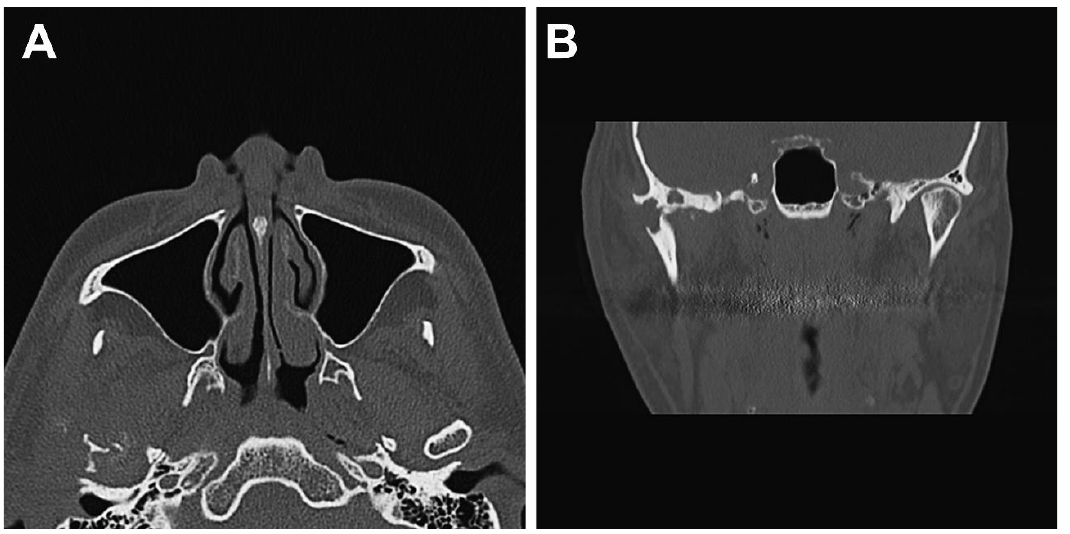
Figure 5. Postoperative computed tomography (CT) images. ( A ) Axial CT images and ( B ) Coronal CT images revealed that the masses were extracted from the right temporomandibular joint.